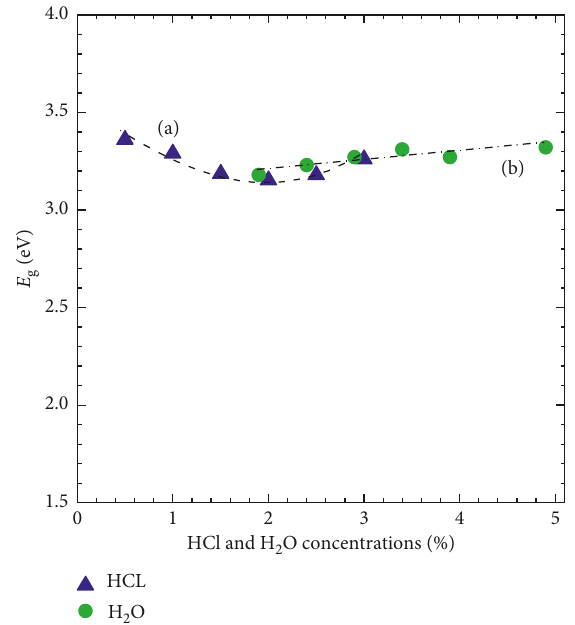
Figure 7: Crystallite size as a function of (a) HCl and (b) H concentrations.